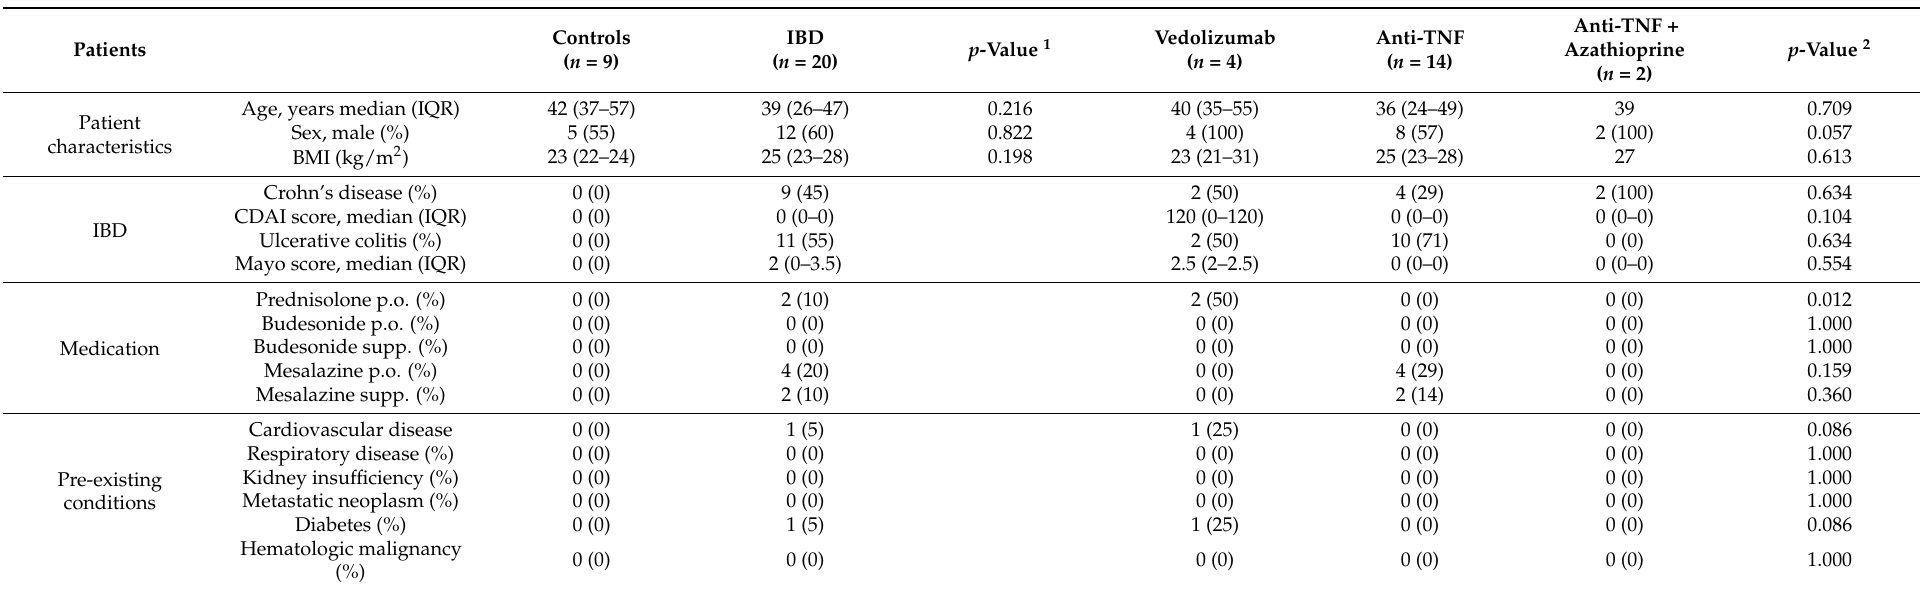
Table 1. Cohort characteristics of IBD patients. Representation of the entire IBD patient cohort and classification of patients by immunosuppressive therapy: vedolizumab, Anti-TNF (adalimumab, infliximab), Anti-TNF + azathioprine. IBD: inflammatory bowel disease; IQR: interquartile range; BMI: body mass